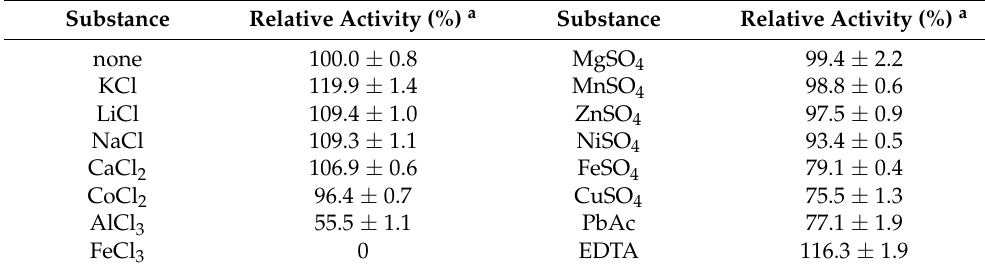
Table 1. Effects of various metal ions and chemical reagents on purified